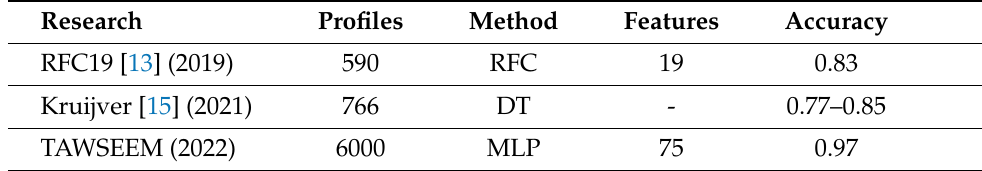
Table 6. TAWSEEM: comparison with other machine-learning-based